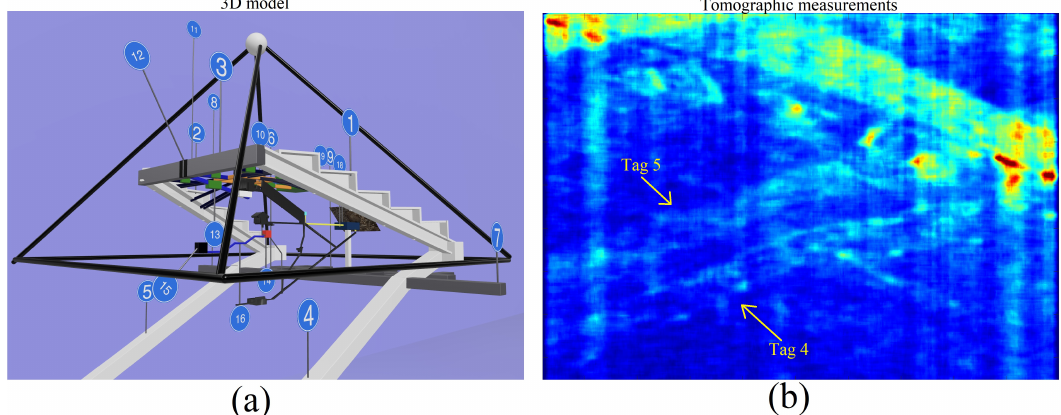
Figure 41. Tags association from tomography to 3D model. ( a ): Three-dimensional (3D) model of Khnum-Khufu (East-side orientation). ( b ): Tomographic reconstruction (magnitude).